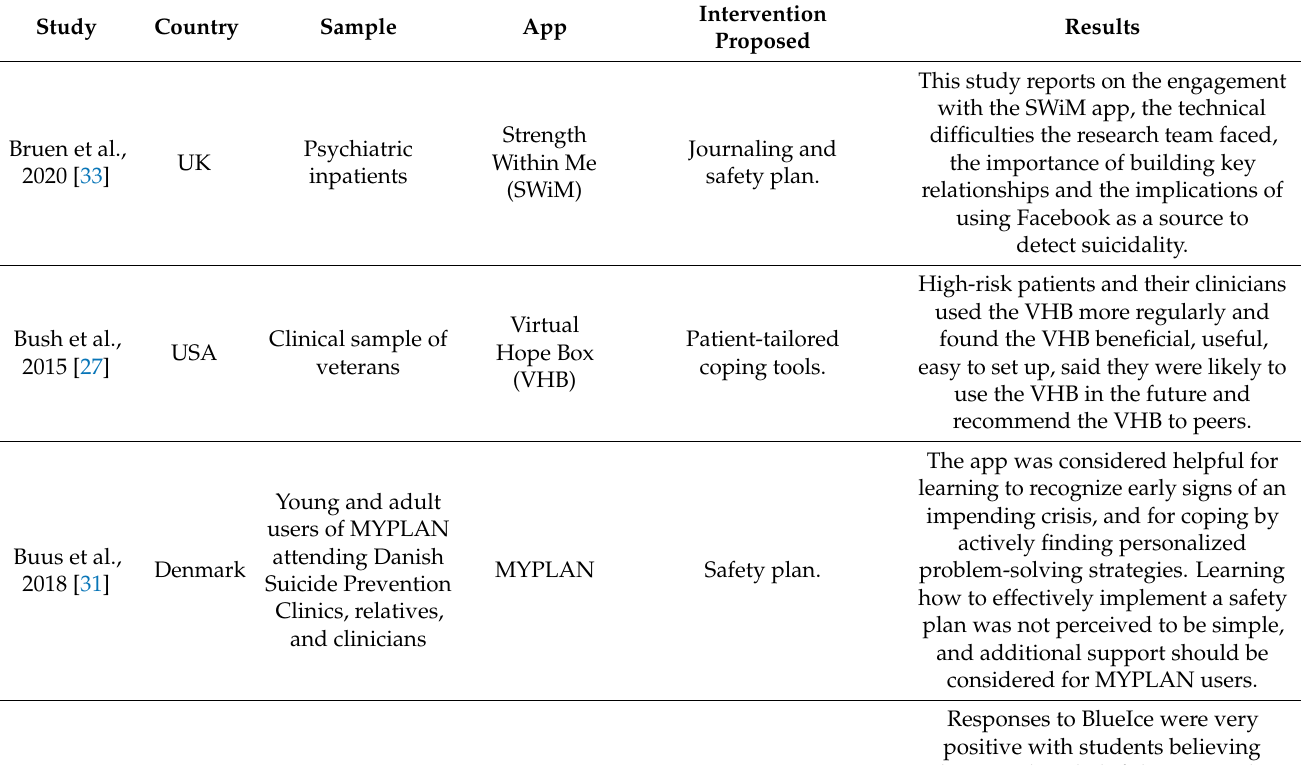
Table 1. Studies on feasibility and acceptability of mobile